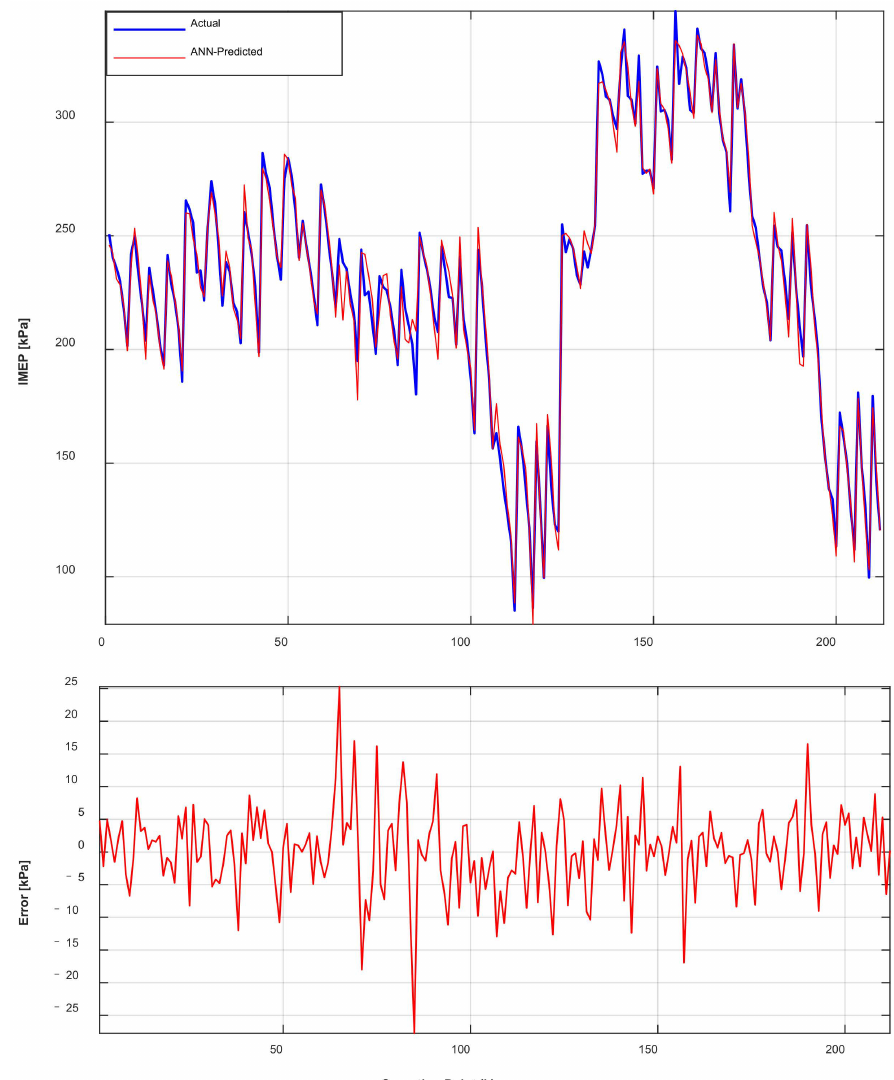
Figure 7. Comparison of the ANN IMEP model and actual